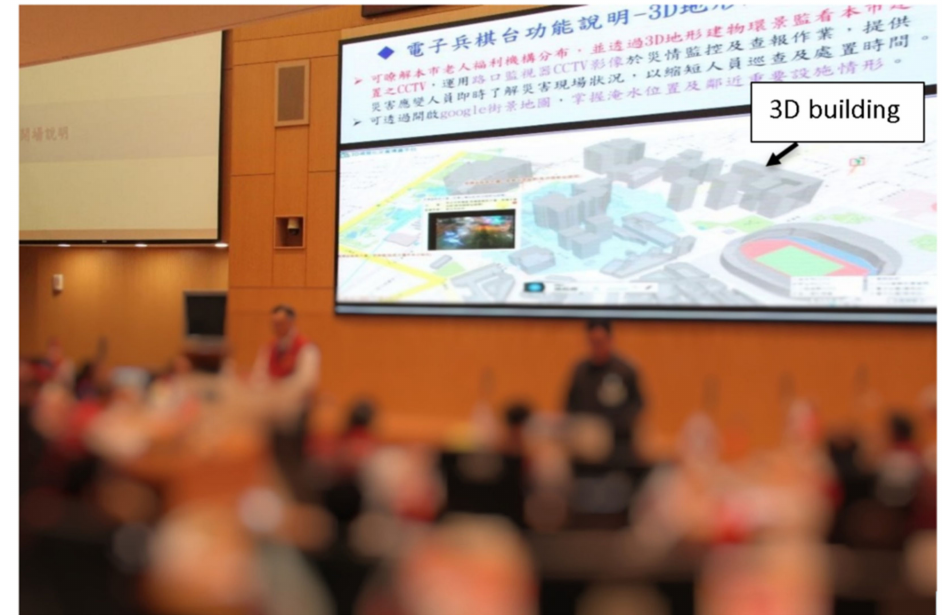
Figure 17. The responsible agencies in New Taipei City using the FWGAP—3D Building (on 31 May 2019). (Photographed by Yong-Jun Lin).